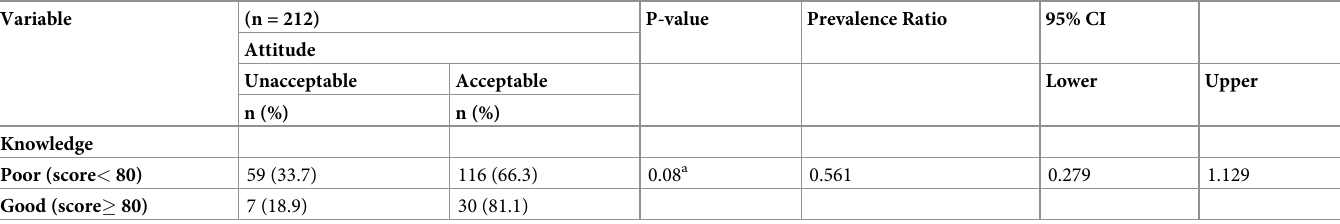
Table 8. Association between knowledge with attitude towards food poisoning among the respondents. Variable